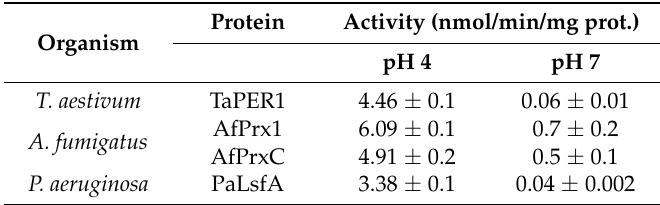
Table 1. PLA 2 specific activity (nmol/min/mg protein) for non-mammalian Prdx6 at different pHs. Organism